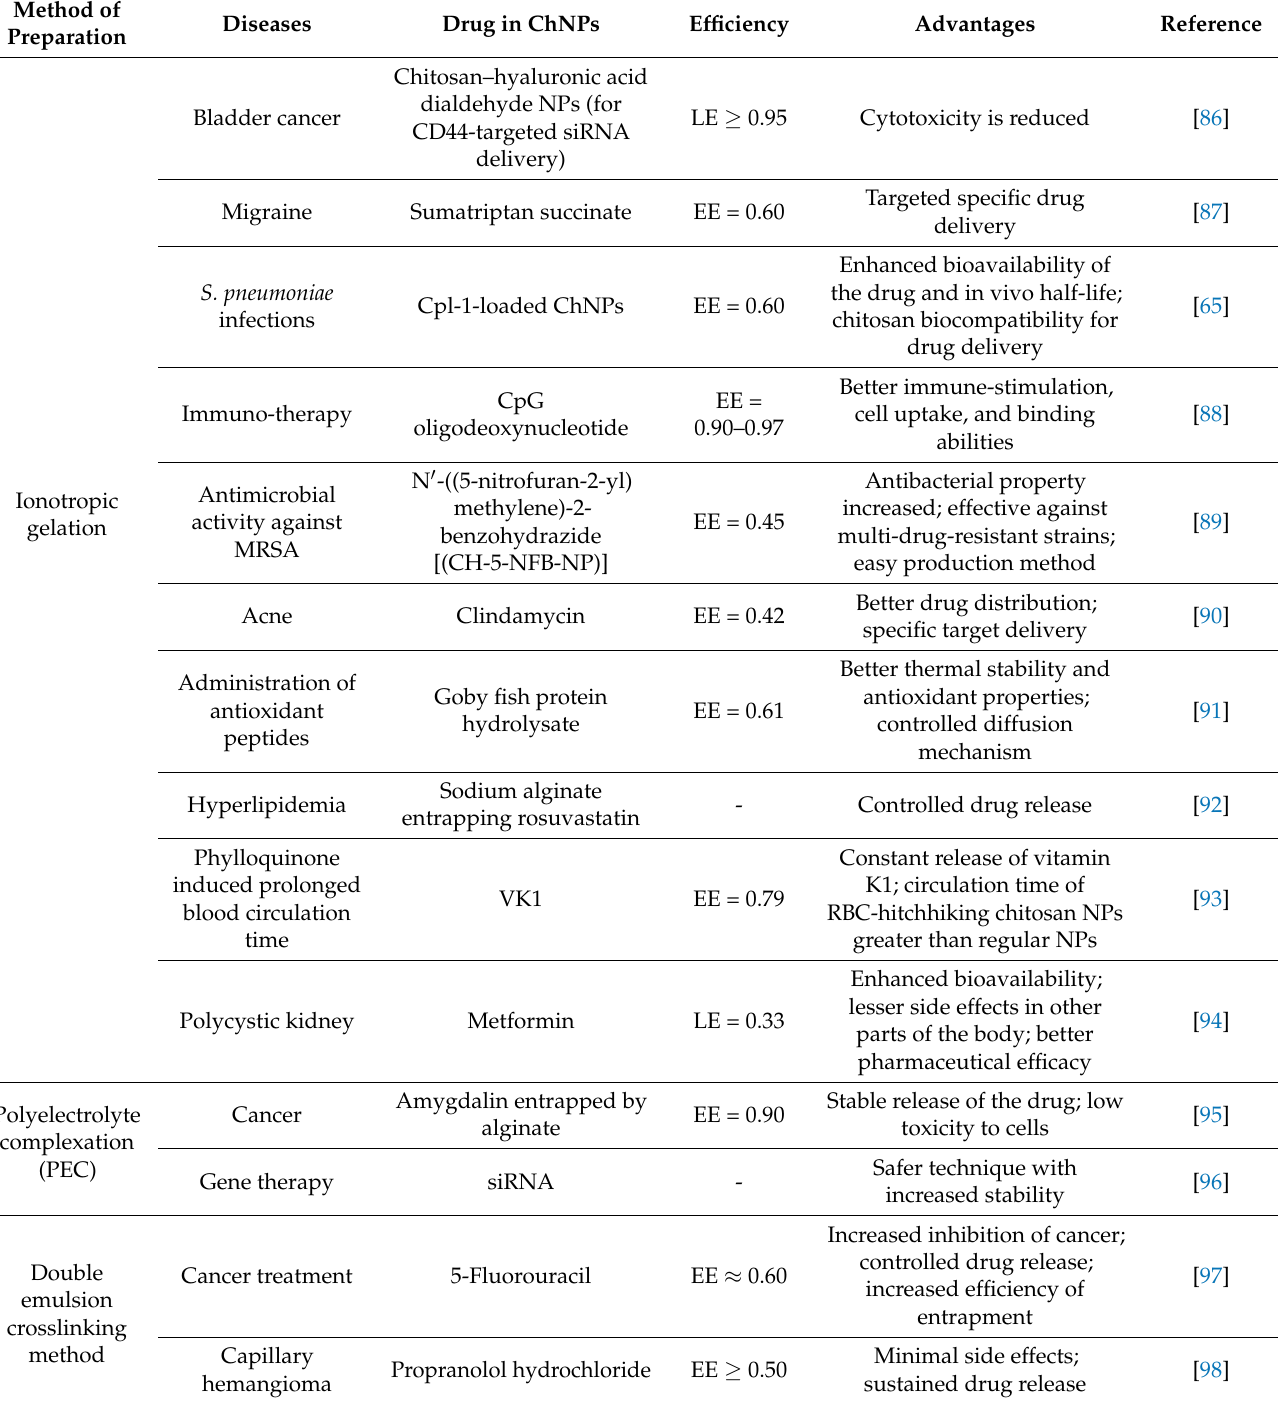
Table 2. ChNPs: preparation methods for various diseases, drugs, efficiencies, and